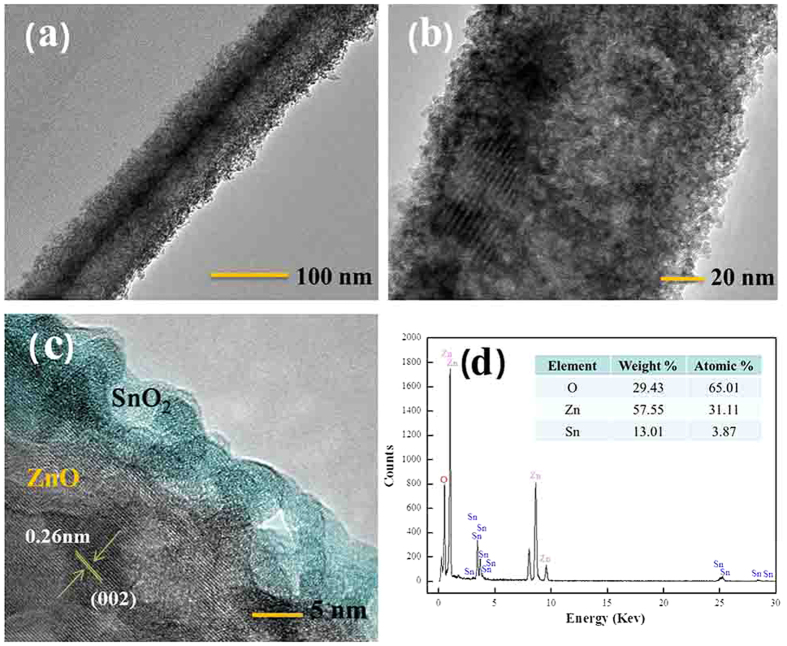
(a) TEM images of ZnSn(OH)6/ZnO composite, (b,c) TEM and HRTEM images of SnO2/ZnO heterojunction, (d) EDS spectrum of SnO2/ZnO heterojunction.